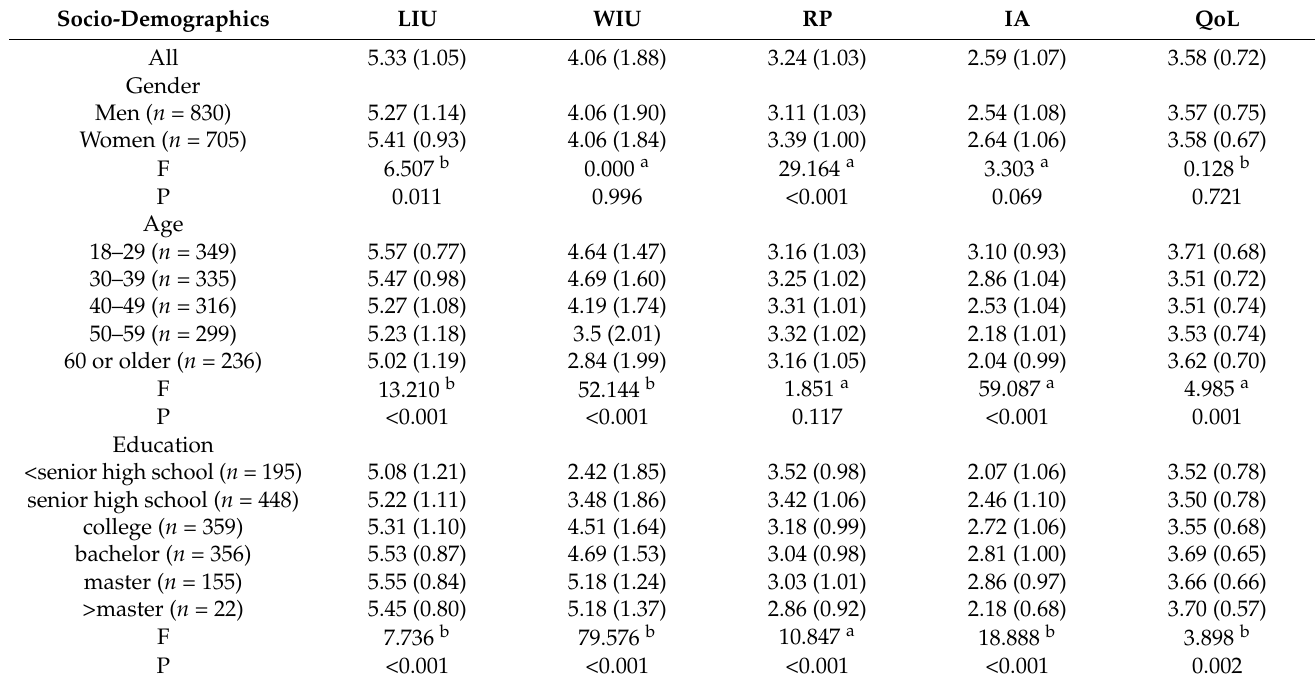
Table 1. Results of mean, SD, and ANOVA ( n =